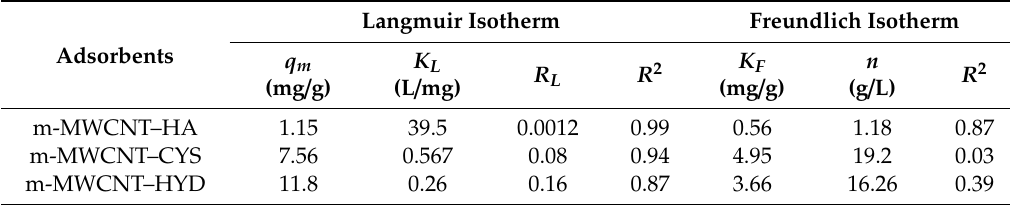
The Langmuir and Freundlich parameters for Ibu adsorption on m-MWCNT–HA, m-MWCNT–CYS, and